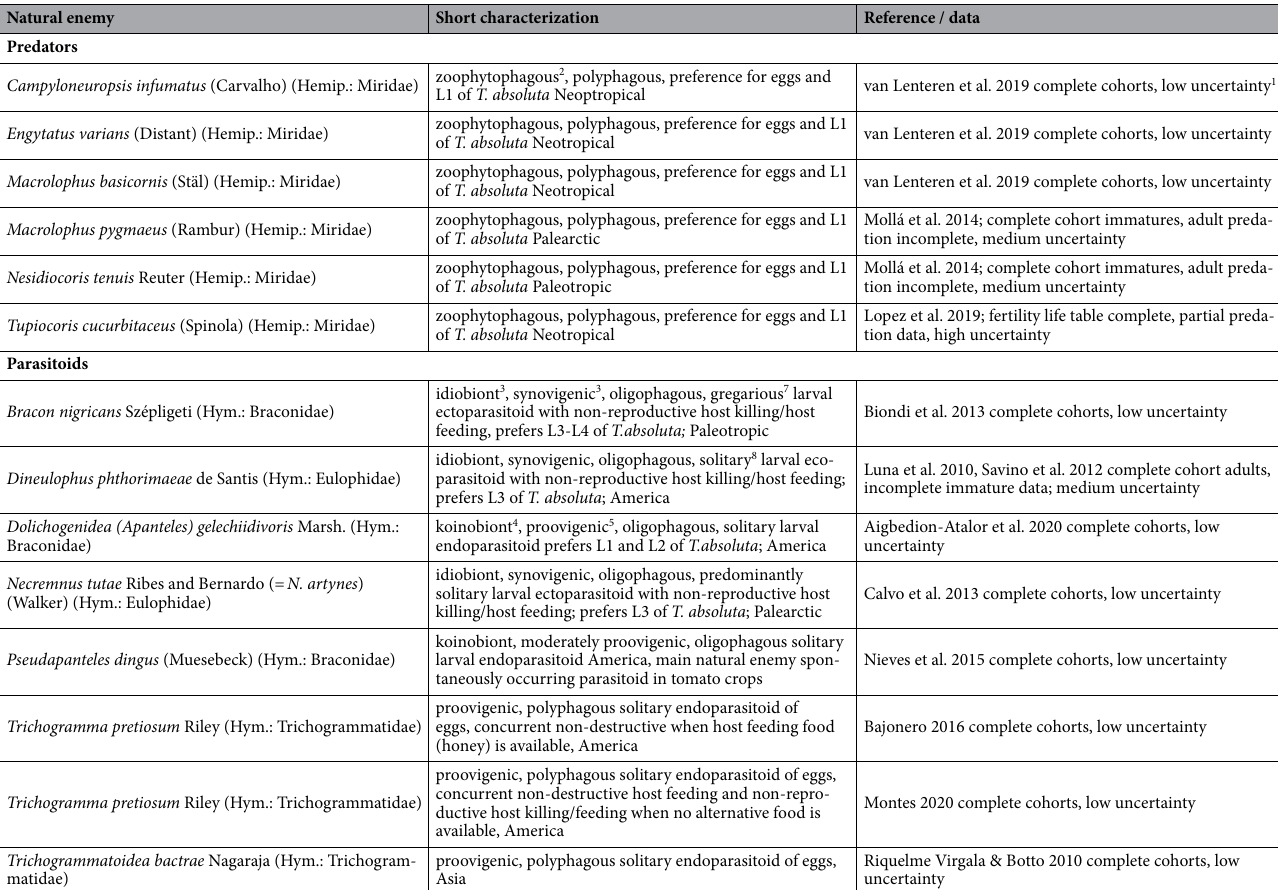
Table 1. Natural enemies of Tuta absoluta used in this study. 1 uncertainty: low = all data needed to calculate pest kill rate available; medium = part of data needed to be estimated; high = many data needed to be estimated; complete cohort data were available for predation and fertility of the predators C. infumatus , E. varians and M. basicornis ; for M. pygmaeus and N. tenuis complete cohort data were available for predation of the nymphal stages and fertility, and partial data for predation by adults; for T. cucurbitaceus, complete data were available for fertility and partial data for predation by nymphs and adults. For six of the seven species of parasitoids, complete cohort data were available for parasitism, non-reproductive host killing and fertility; for D. phtorimaeae complete cohort data were available for the adult stage, but some data for immature development had to be estimated; 2 zoophytophagous = eats arthropods and feeds on plants; 3 idiobiont = paralysis of host at oviposition, no further development of host; 4 koinobiont = host continues development after being parasitized; 5 proovigenic = most eggs are mature at emergence; 6 synovigenic = eggs mature after emergence; 7 gregarious = more than one parasitoid can develop on a host; 8 solitary = one parasitoid develops per